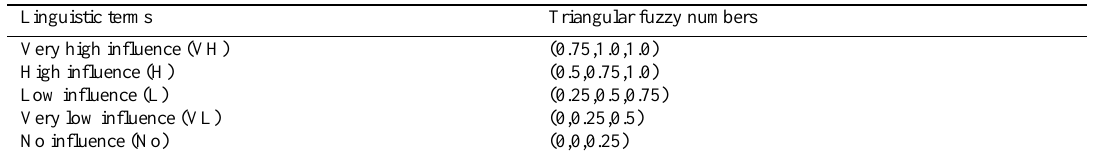
Table 11. Fuzzy linguistic